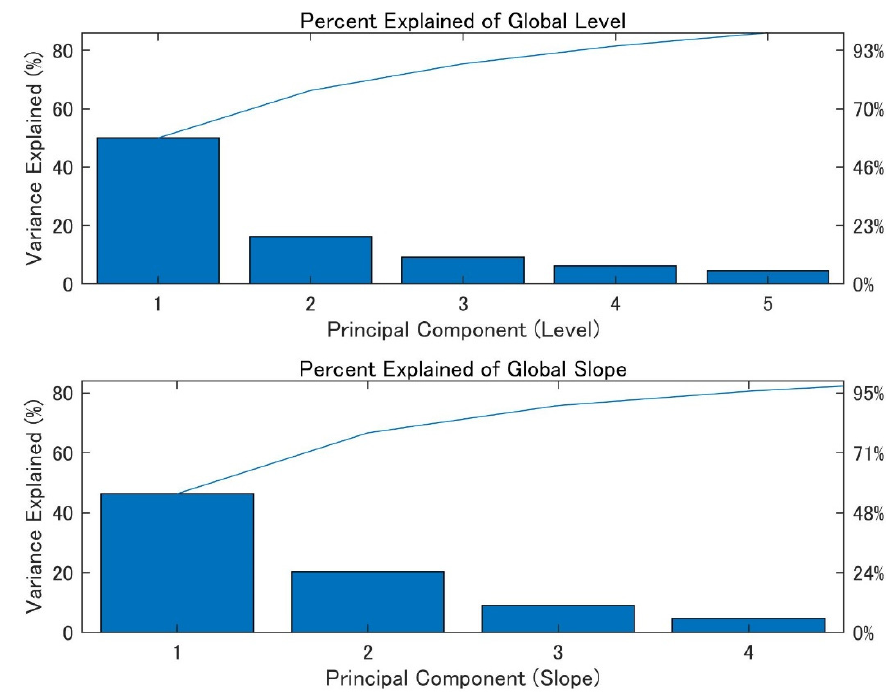
Figure 2. Principal Component Analysis.